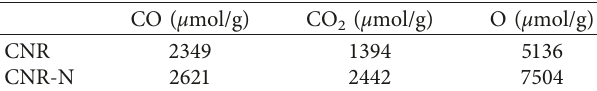
Figure 1: TPD spectra: (a) CO and (b) CO 2 desorption profiles as a function of temperature for CNR and CNR-N samples. Table 1: Quantitative results of the TPD-MS analysis for carbon